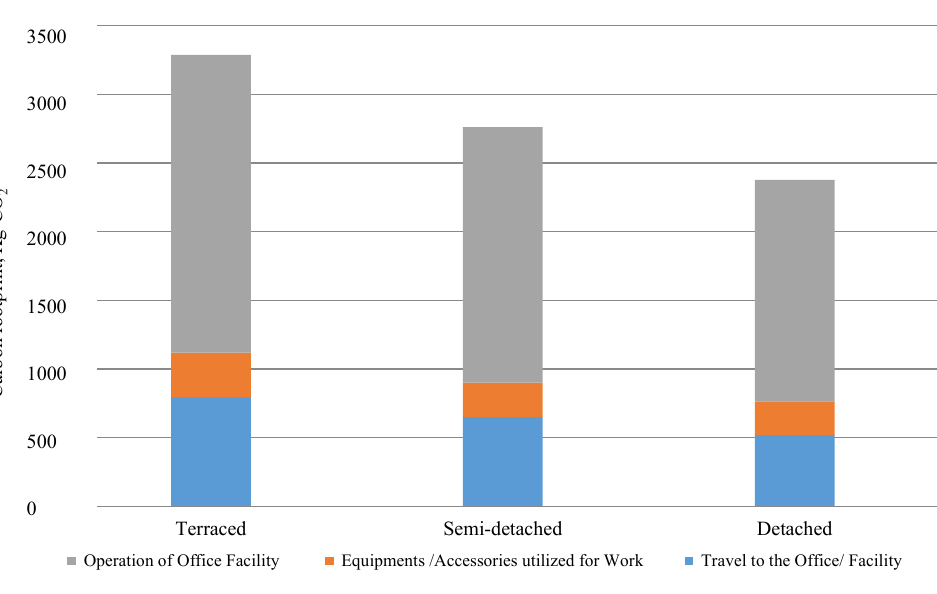
Fig. 1. Head wise contribution of carbon footprint during the P&D